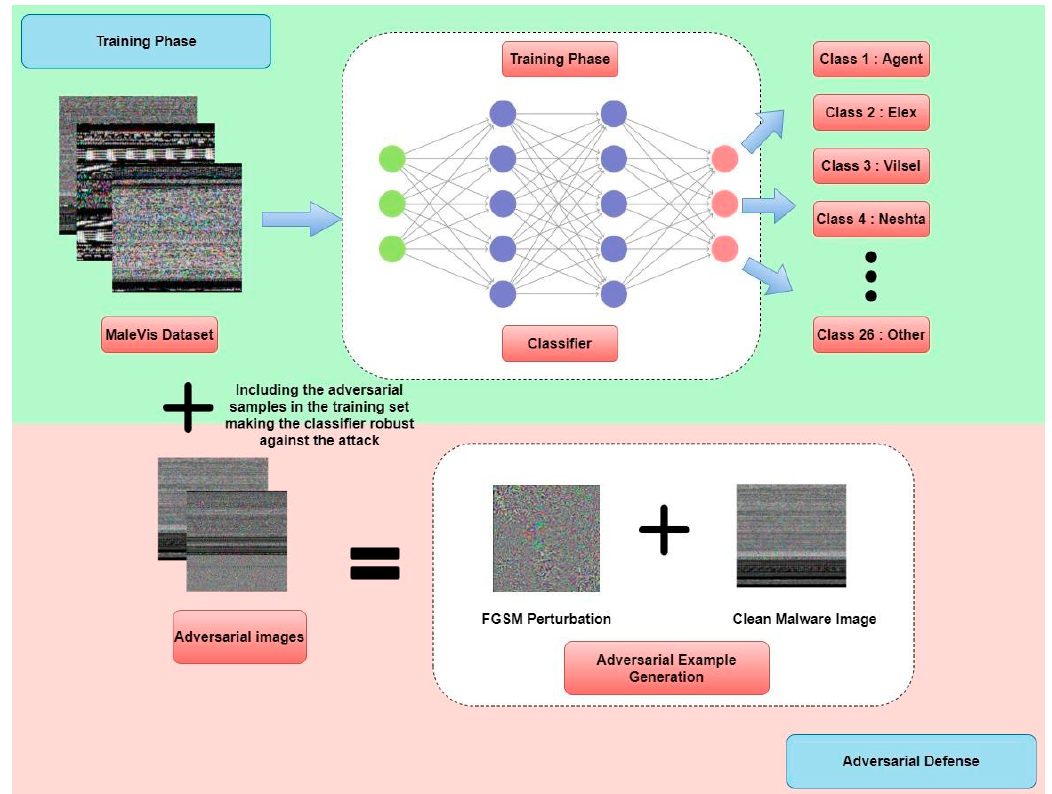
Figure 11. Schematic representation of adversarial defense performed.